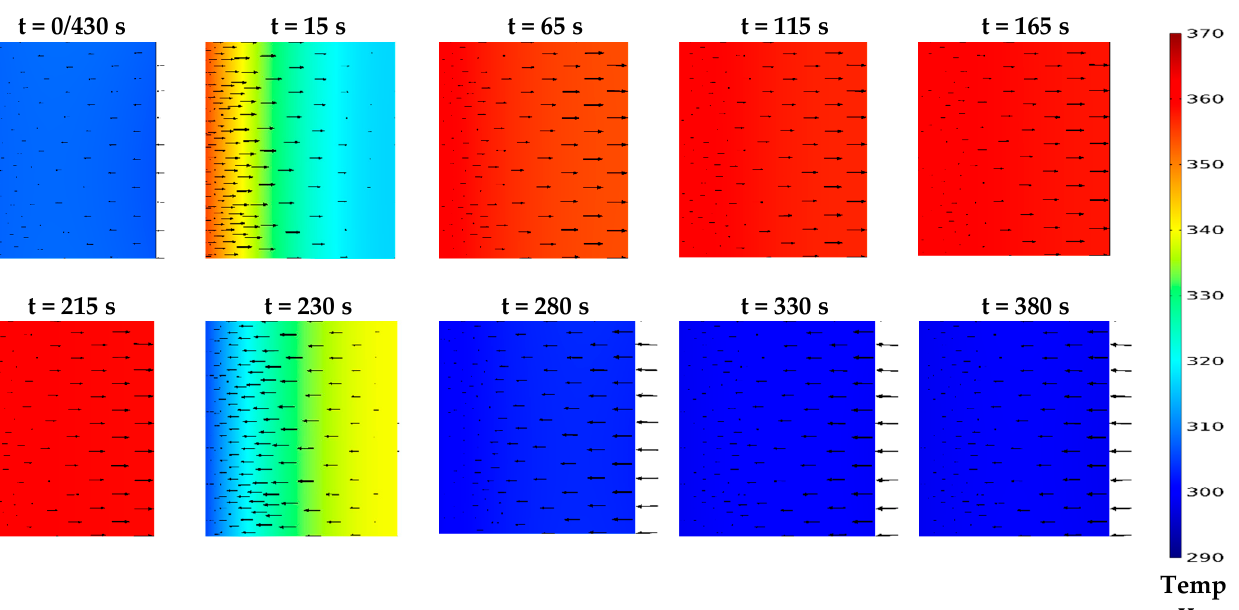
Figure 5. The temperature distribution during the whole cycle at different time steps for the consol- idated form.